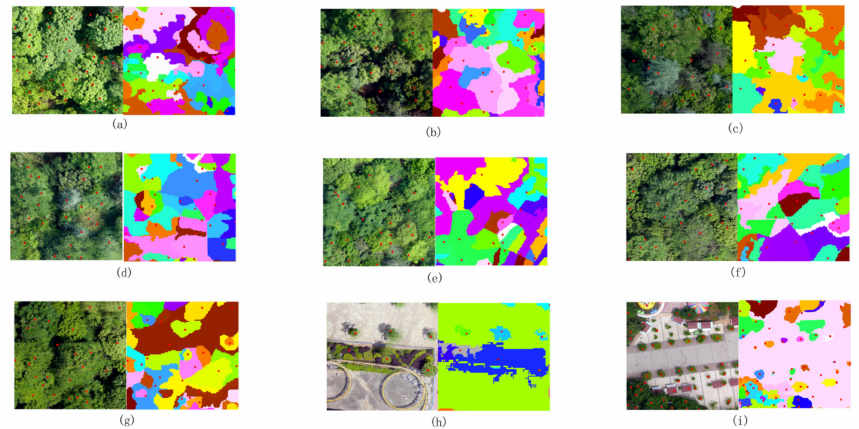
Figure 12. The detected vertex and the segmentation results of the sample plots: ( a – h ) The detected vertex of plot 1 to plot 8; ( i ) the detected vertex of individual